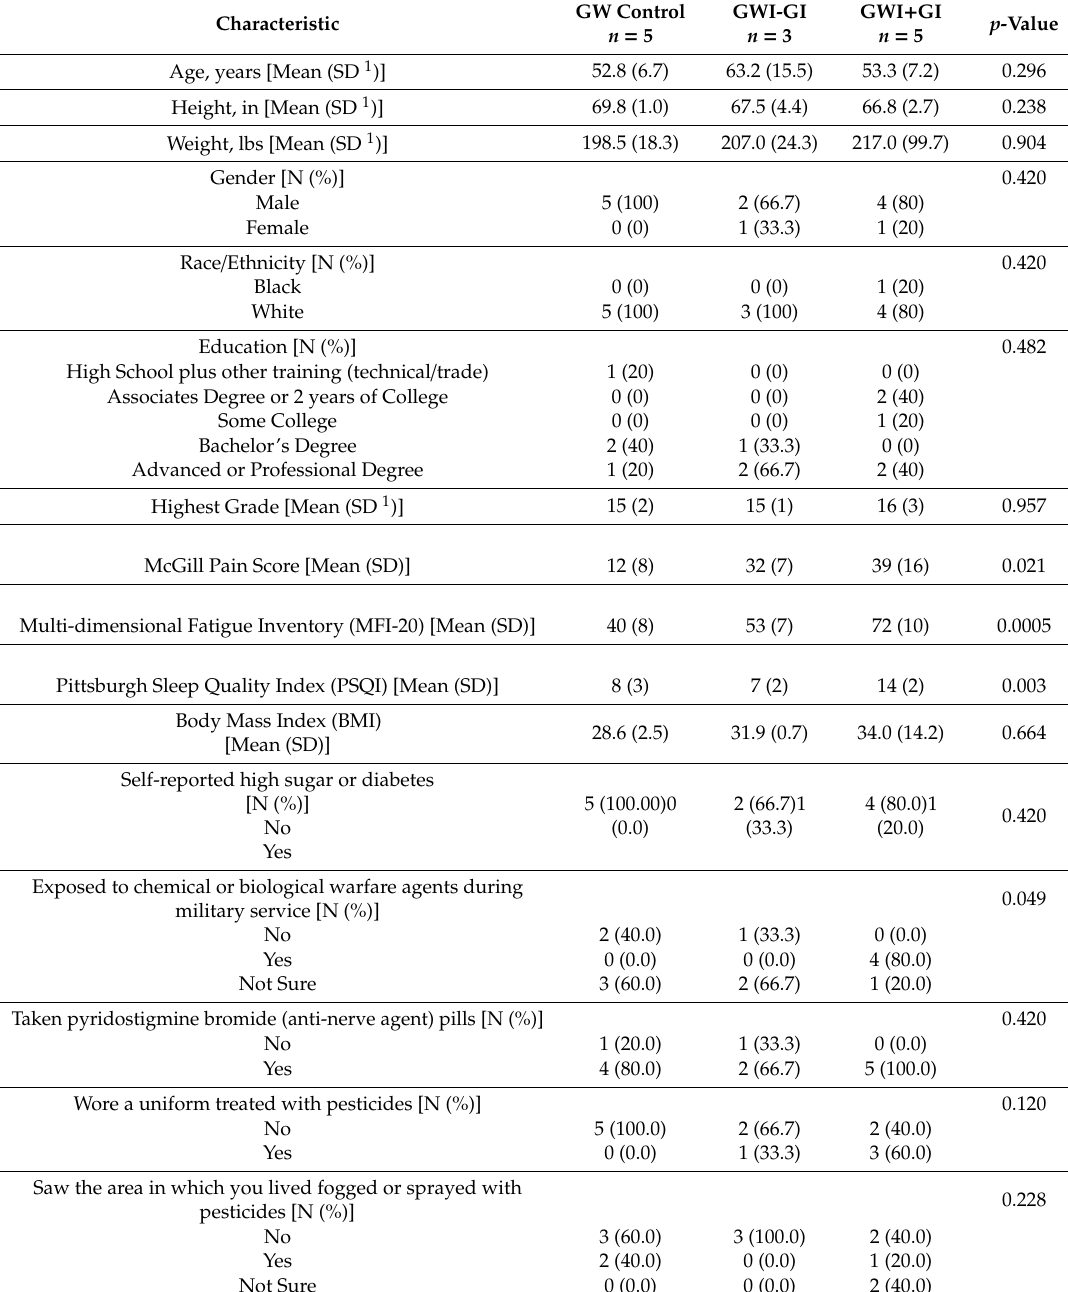
Table 1. Demographic and Exposure Characteristics of